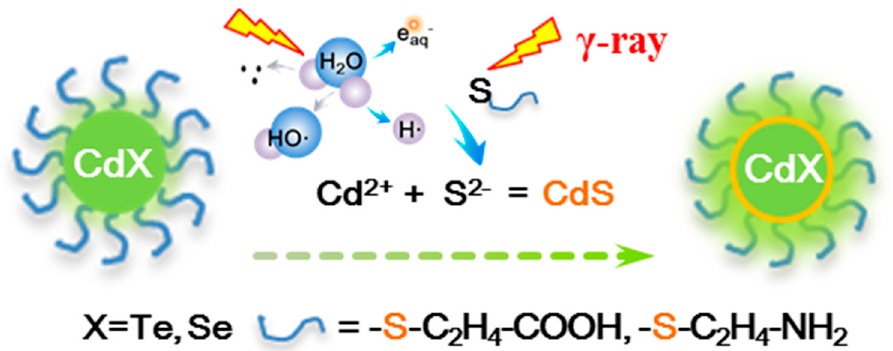
Figure 8. Schematic diagram of the mechanism of γ -radiation-induced luminescence enhancement of thiol-capped QDs in the aqueous solution .